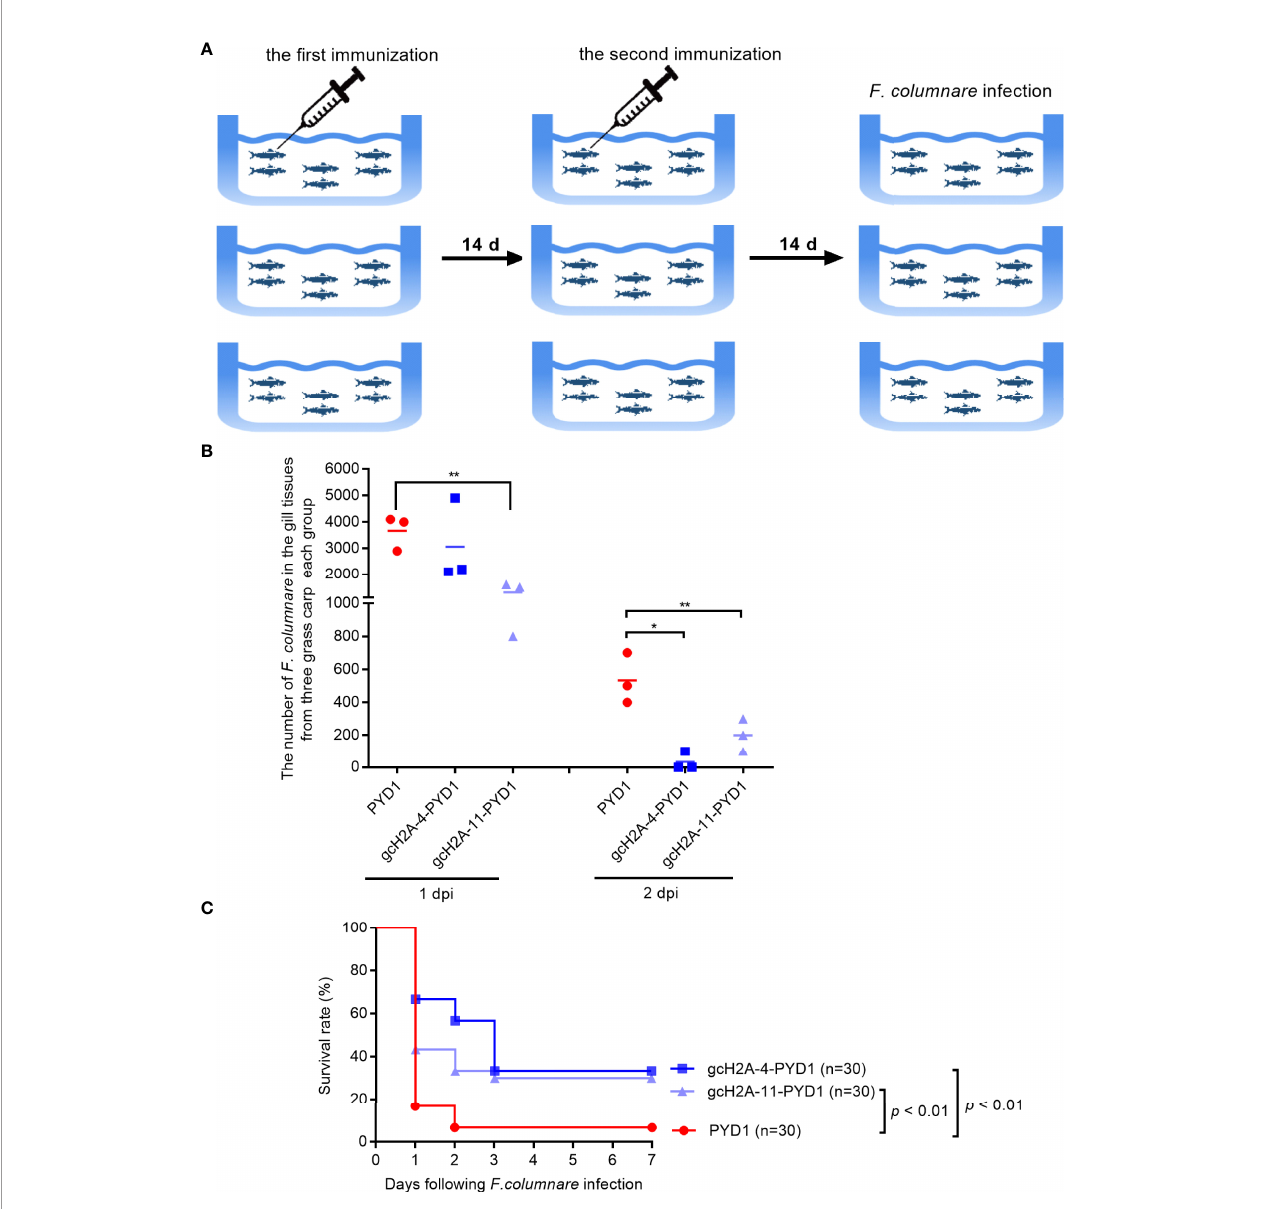
FIGURE 8 | The effects of the engineered S. cerevisiae expressing gcH2A-4 and gcH2A-11 on the disease resistance of grass carp against F. columnare infection. (A) The schematic diagram for the immunized grass carp used for survival analysis. (B) The effects of the engineered S. cerevisiae expressing gcH2A-4 and gcH2A- 11 on the bacteria proliferation of F. columnare Data represented means ± SEM (n=3), and were tested for statistical signi fi cance. * p < 0.05; ** p < 0.01. (C) The effects of the engineered S. cerevisiae expressing gcH2A-4 and gcH2A-11 on the survival of grass carp in response to F. columnare